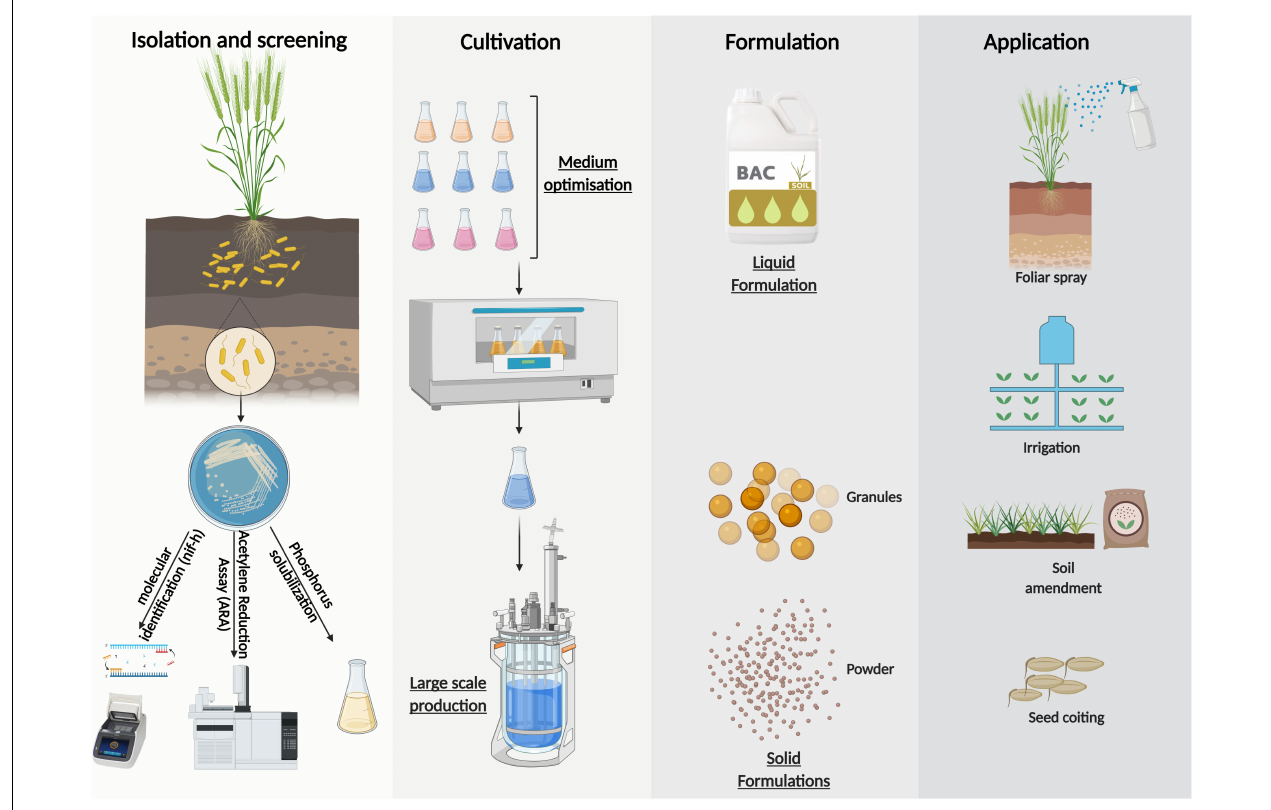
FIGURE 4 | Formulation possibilities and large-scale production of inoculants from Azotobacter